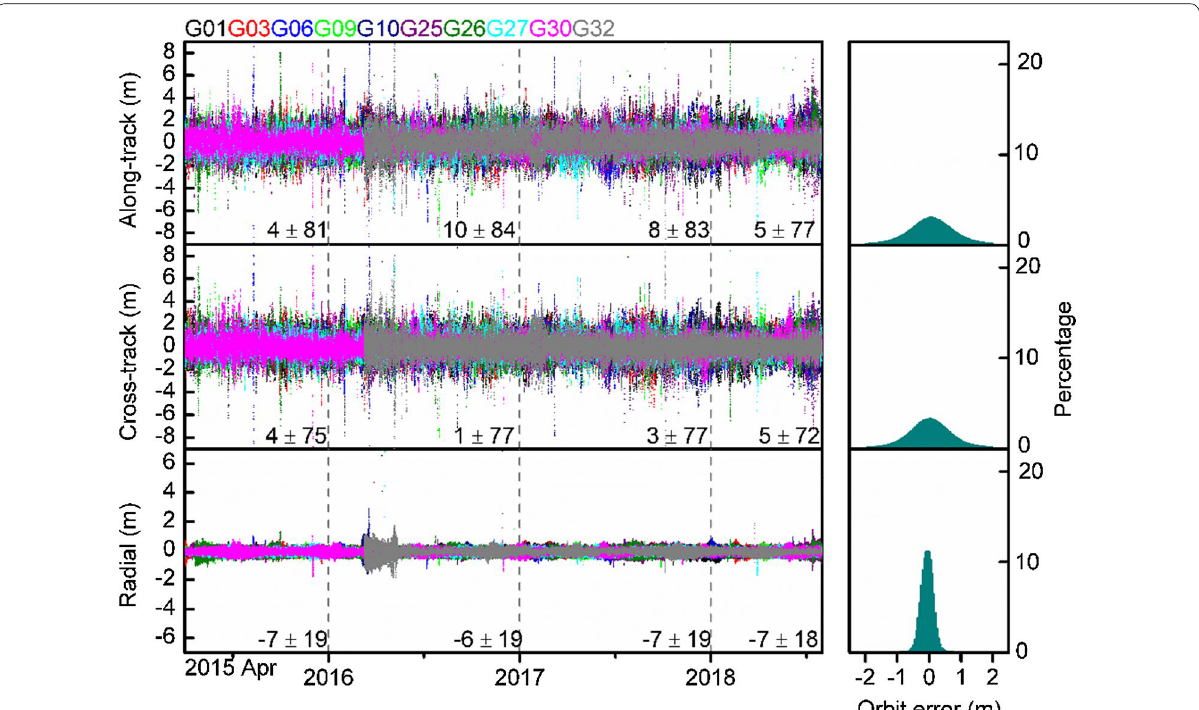
Fig. 4 Time series of GPS IIF LNAV broadcast orbit errors ( left ) and the frequency histogram ( right ). Mean and STDs for each year are indicated at the bottom in centimeters